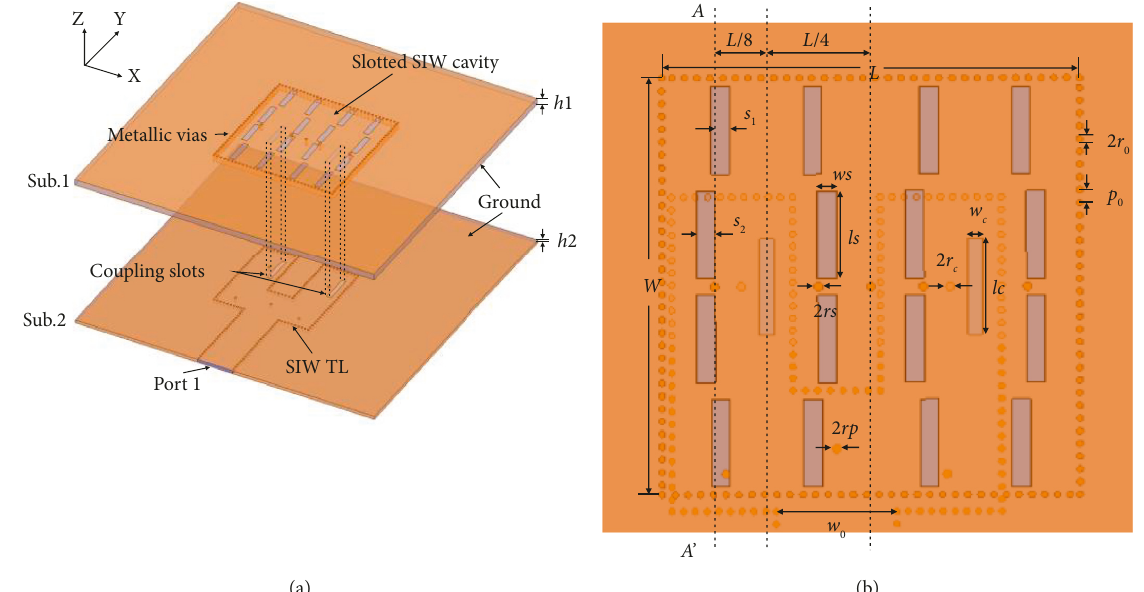
Figure 2: Configuration of the antenna element. (a) Perspective view. (b) Top view.